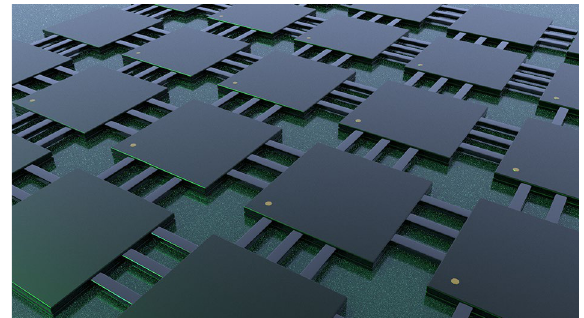
Figure 1. The schematic diagram of a proposed multi-degree optical switch based on the silicon photonic waveguide structure. This is a 2D grid of M × N photonic chips. Each photonic chip is a 3 × 3 × 3 × 3 four- directional structure controlled by thermooptic phase shifters using titanium metallic thin